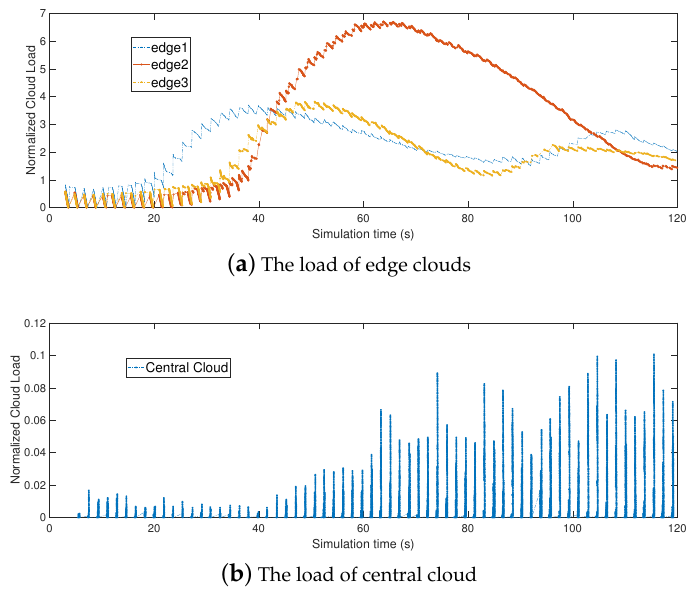
Figure 8. The normalized load of clouds along with simulation